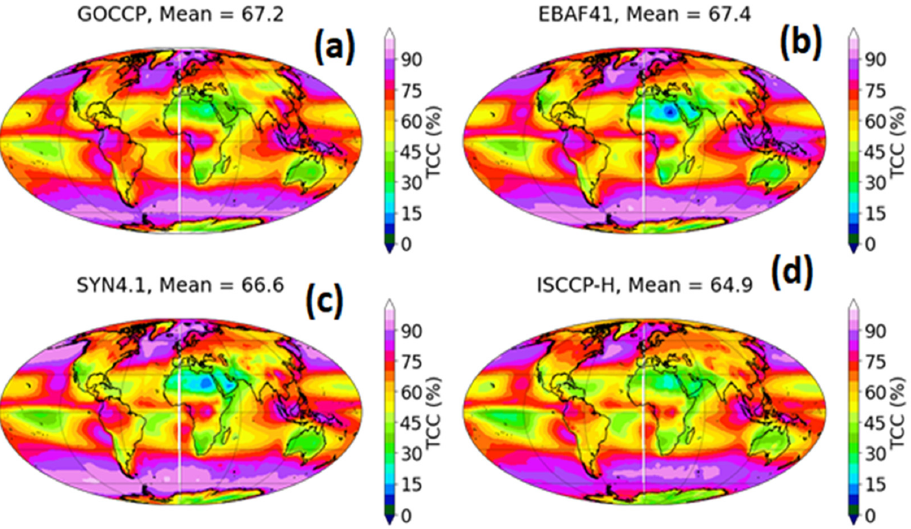
Figure 4. Global maps of annually averaged TCC based on GOCCP-CALIPSO ( a ), EBAF4.1 ( b ), SYN4.1 ( c ), and ISCCP-H ( d